Question: What does this figure show? Answer in one sentence.
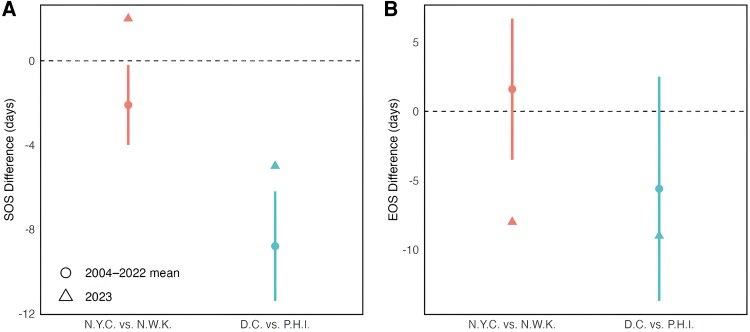
Answer: Comparison of differences in SOS (a) and EOS (b) between paired cities with and without ALAN-mitigation policies, based on long-term means (2004–2022) and postpolicy periods (2023 only). Values are calculated by subtracting phenology at ALAN policy cities from nonpolicy cities for each pair (e.g. NYC vs. Newark; DC vs. Philadelphia). Positive values indicate later phenological timing in policy cities relative to nonpolicy cities. Error bars represent 1 SD across the prepolicy years.